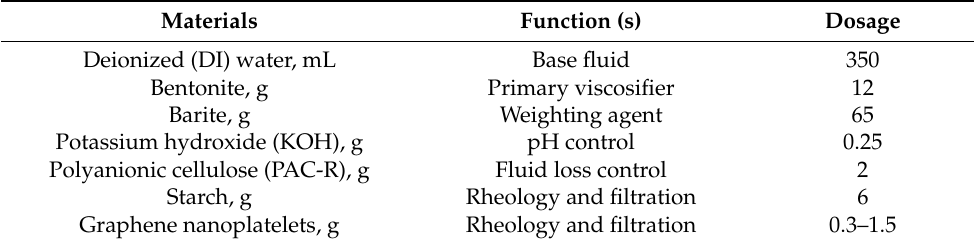
Table 2. Water-based drilling muds formulation.